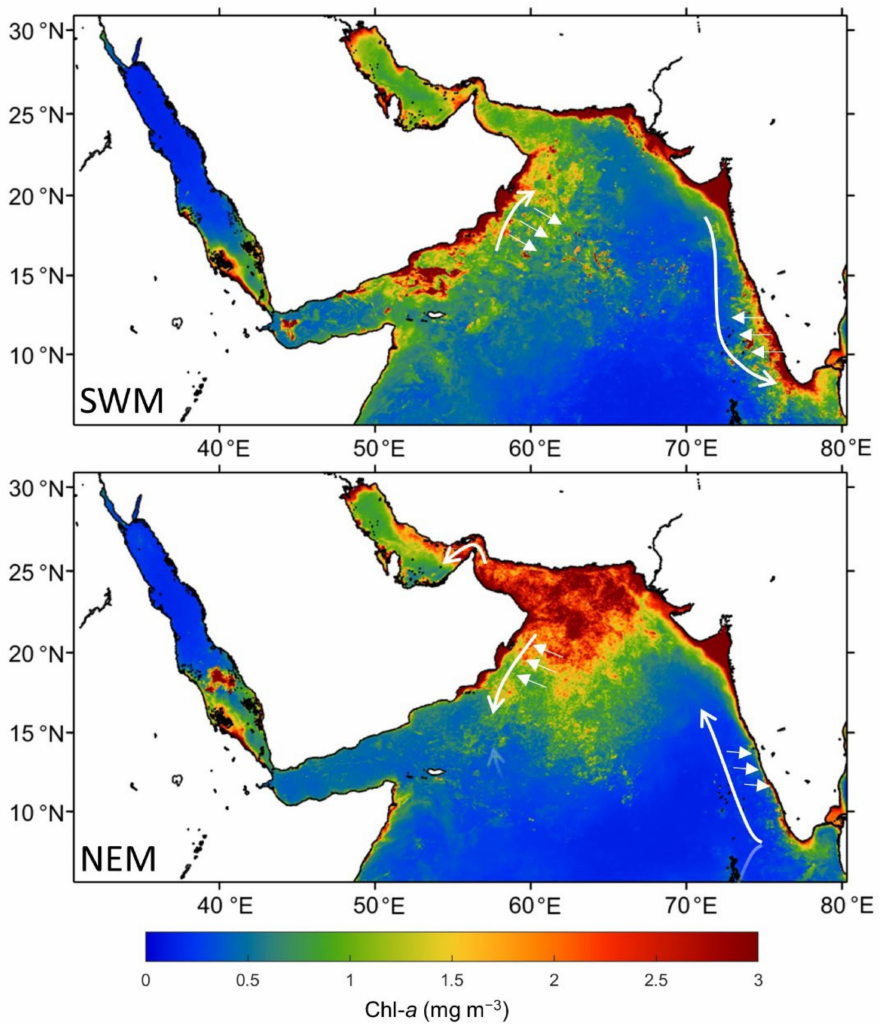
Figure 4. Maximum surface Chl- a concentrations in the NIO during SWM and NEM, retrieved from the satellite data for the years 2002–2020. The red color indicates the highest Chl- a , and the blue color shows the lowest Chl- a concentrations. White arrows indicate the directions of the horizontal movements of algae during SWMs and